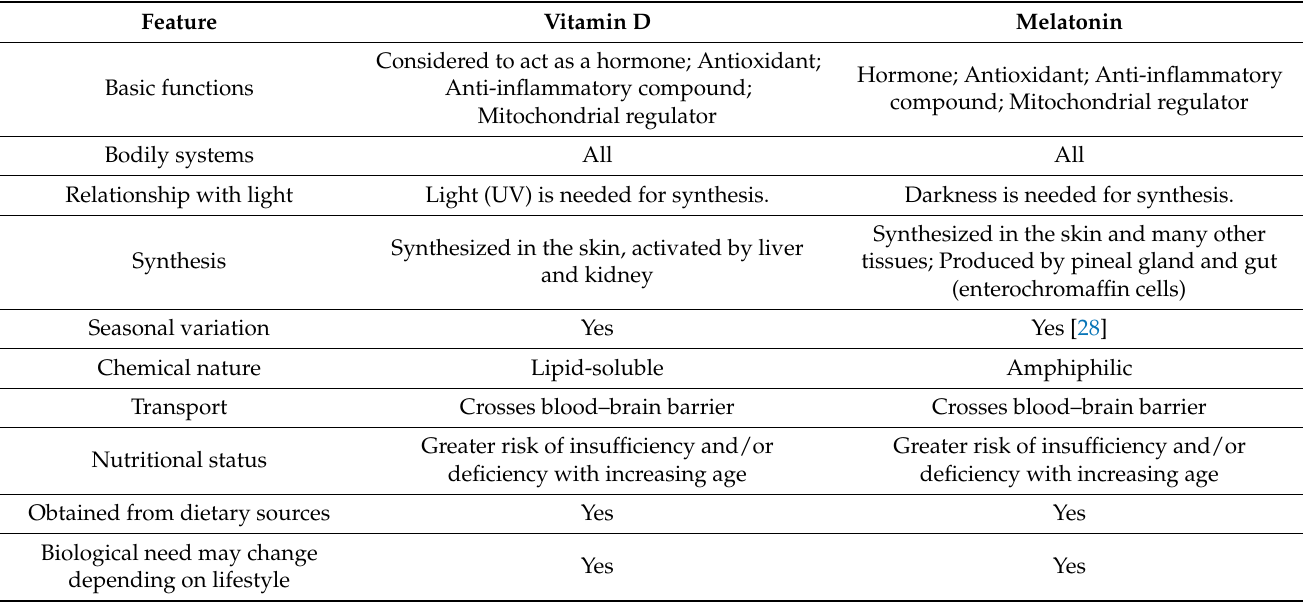
Table 1. Comparison of vitamin D and